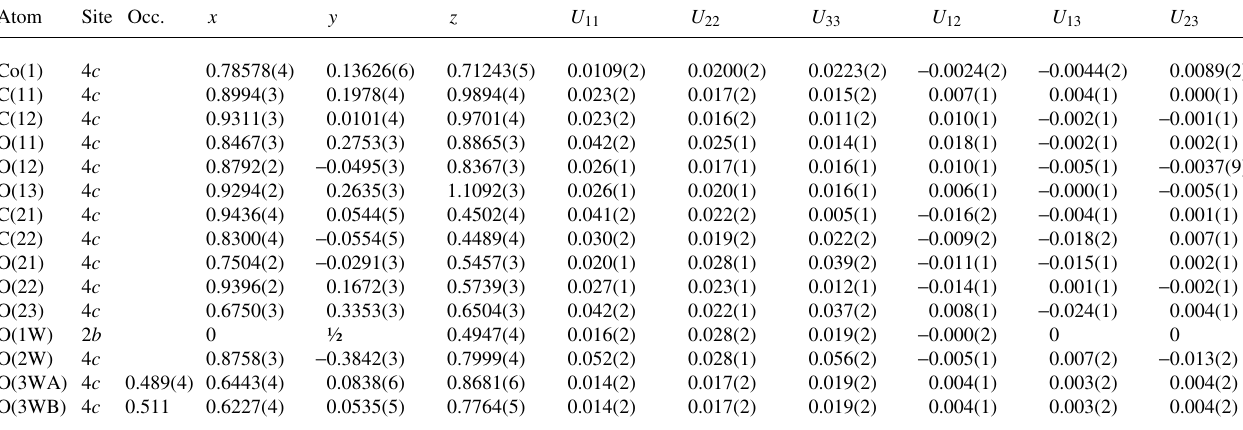
Table 3. Atomic coordinates and displacement parameters (in Å 2 ) . Atom Site Occ.